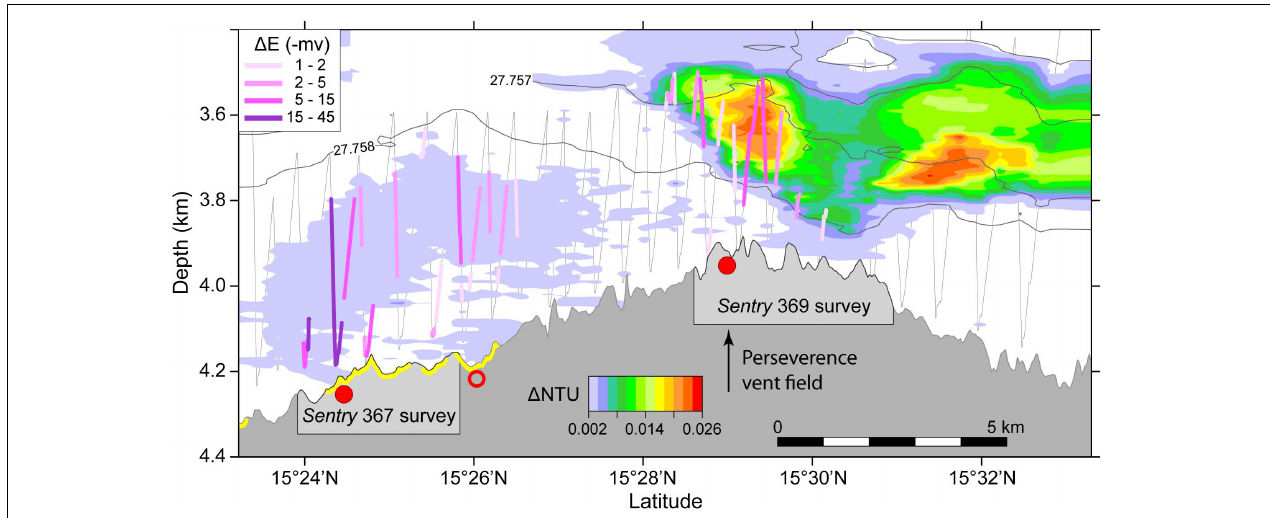
FIGURE 3 | Depth cross-section along the axis of the 15.5 ◦ N segment of the Mariana back-arc showing data from CTD tow T15B-06 (from Baker et al., 2017). Gray is seafloor profile. Colors above seafloor show turbid particle plumes as (cid:49) NTU anomalies. Colored lines along CTD tow path (gray zigzag lines) show (cid:49) E anomalies in millivolts from ORP sensor (see inset for scale). Red dots are confirmed (solid) or inferred (open) hydrothermal sites from Baker et al. (2017). Yellow highlight on the bathymetry profile indicates extent of new lava flows. Note relatively high (cid:49) E but low (cid:49) NTU anomalies over new lava flows, and high (cid:49) NTU and lower (cid:49) E anomalies over northern-most hydrothermal site, at the Perseverance vent field with black-smoker chimneys.